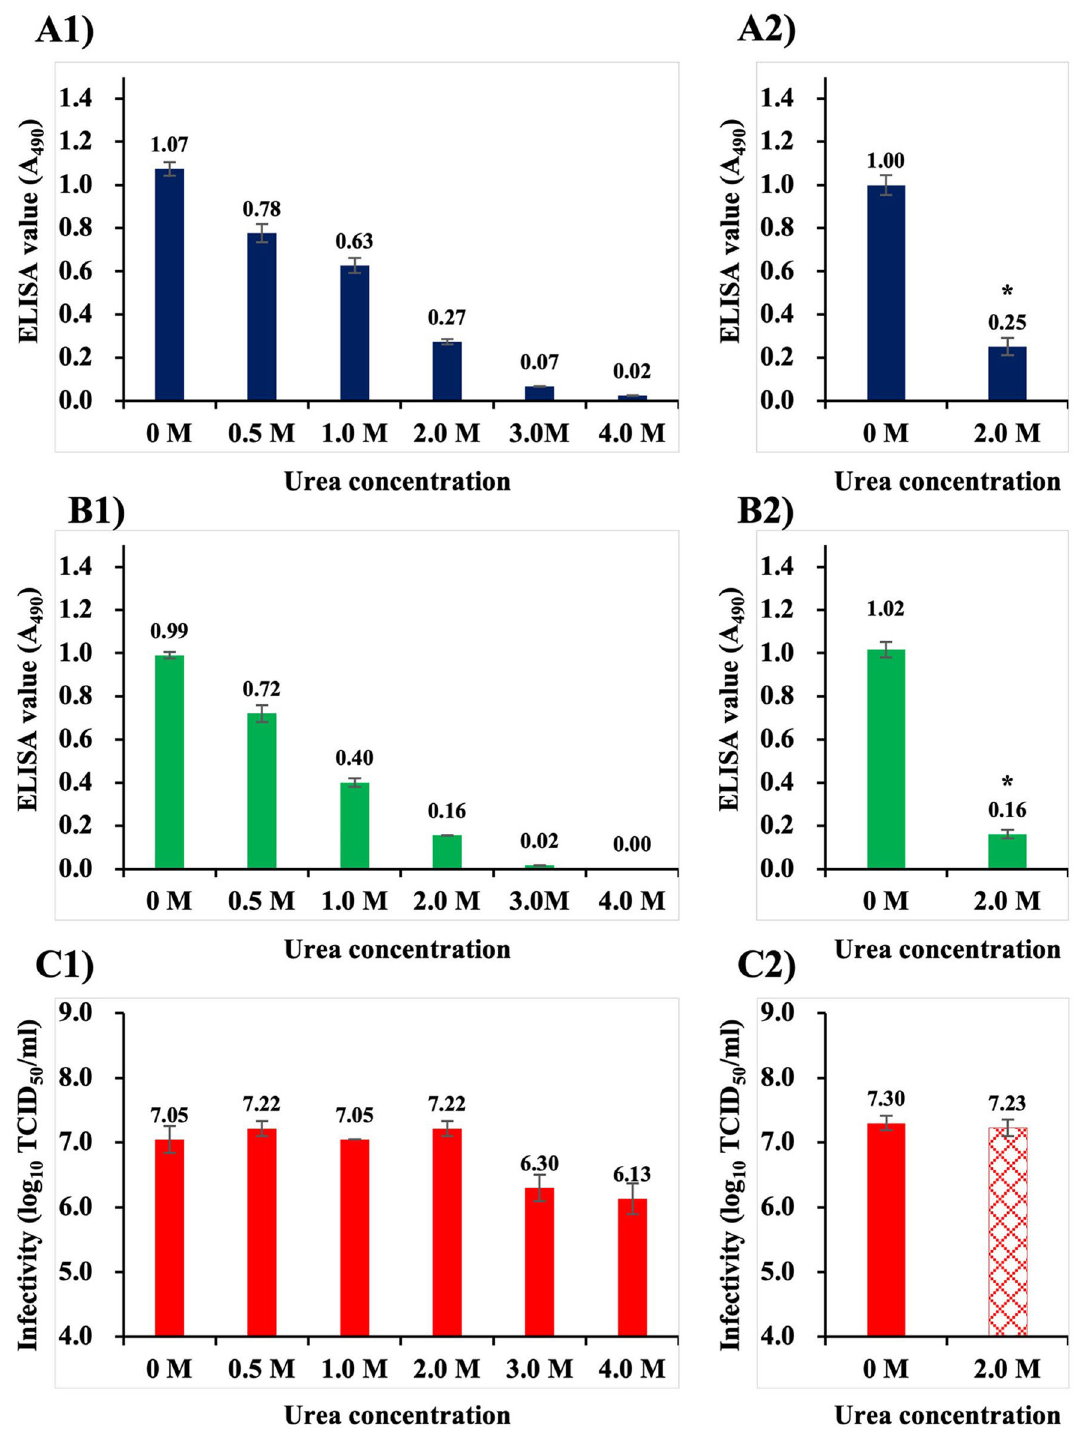
Figure 3. Alteration in antigenicity and infectivity of NNV particles following treatments at different urea concentrations. Purified NNV particles were treated with urea solutions at 25 °C for 24 h. ( A ) Alteration of NNV antigenicity detected with anti-NNV PAb, ( B ) detection with anti-NNV MAb, ( C ) alteration of NNV infectivity. (1) Results of a single set of experiments using the same sample on the same day. (2) The same experiments were conducted five times on different days, but limited to treatments at 0 and 2.0 M urea. Error bars indicate SD. *: Significant difference (ρ < 0.05) compared to the values for 0 M urea